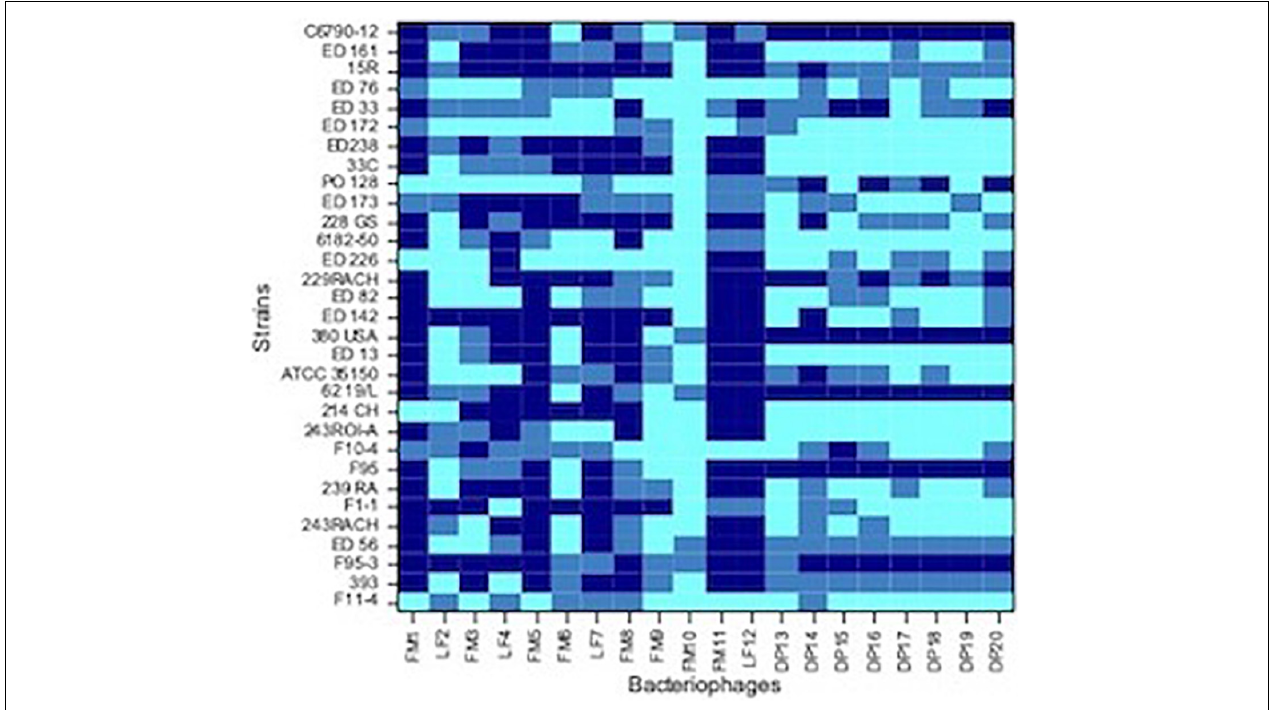
FIGURE 2 | Heat-map showing the host range of each isolated phages. Dark blue, no sensitive strain; medium blue, strain with low sensitivity; light blue, strain with high sensitivity.